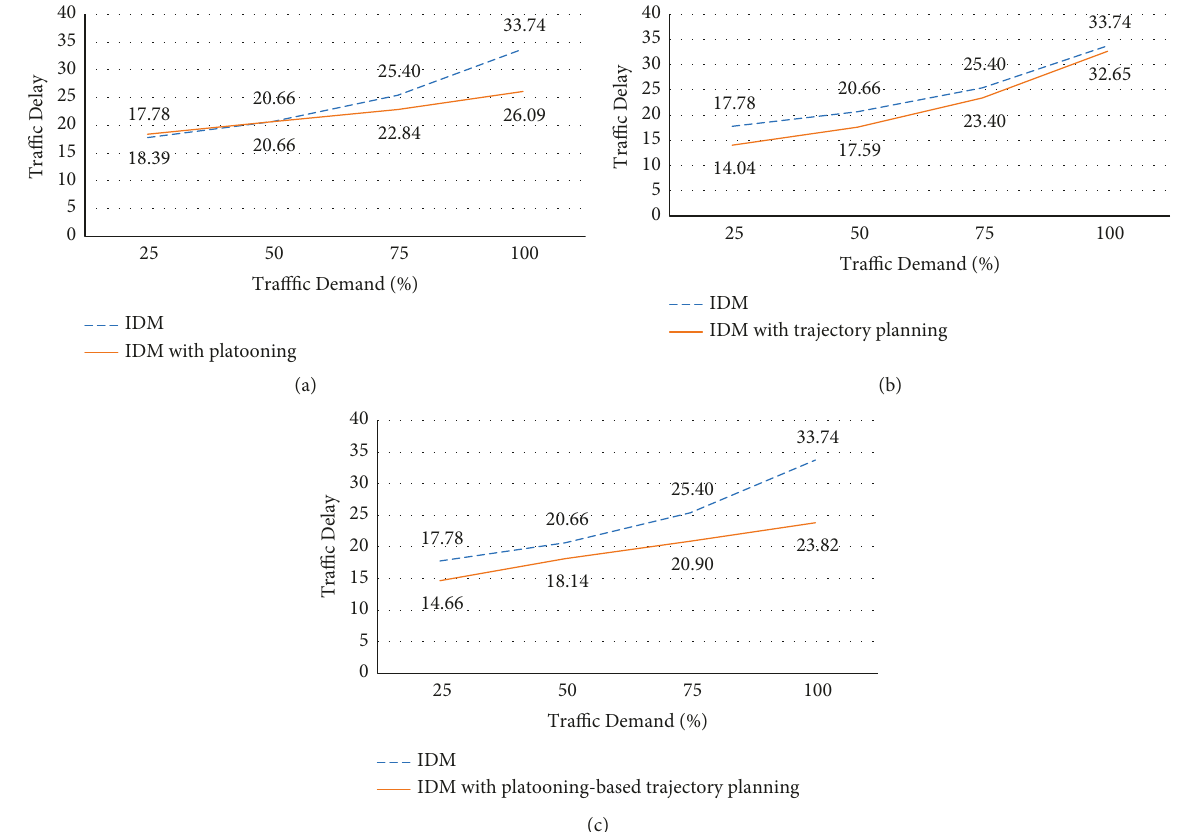
Figure 7: Average traffic delay(s) of CAVs in the equivalent conventional intersection. (a) Average traffic delay for IDM and IDM with platooning (b) Average traffic delay for IDM and IDM with trajectory planning. (c) Average traffic delay for IDM and IDM with platooning- based trajectory